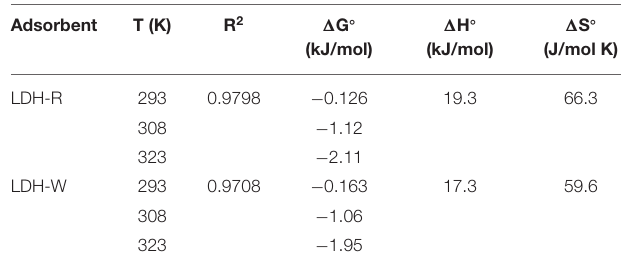
TABLE 3 | Thermodynamic parameters of Orange II adsorption onto the studied